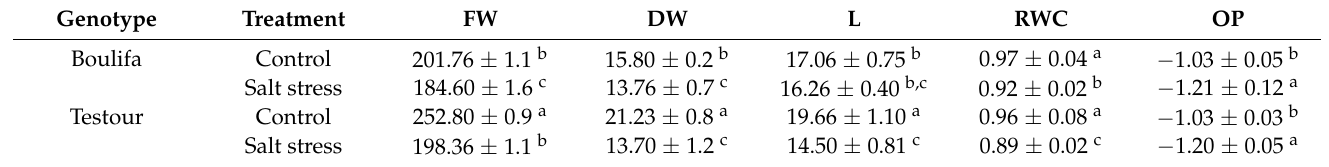
Figure 1. Phenotype of Boulifa (B, right ) and Testour (T, left ) grown under control conditions (C) and salt (200 mM NaCl) treatment (S) for 24 h. Table 1. Growth parameters in leaves of control and salt-stressed seedlings.